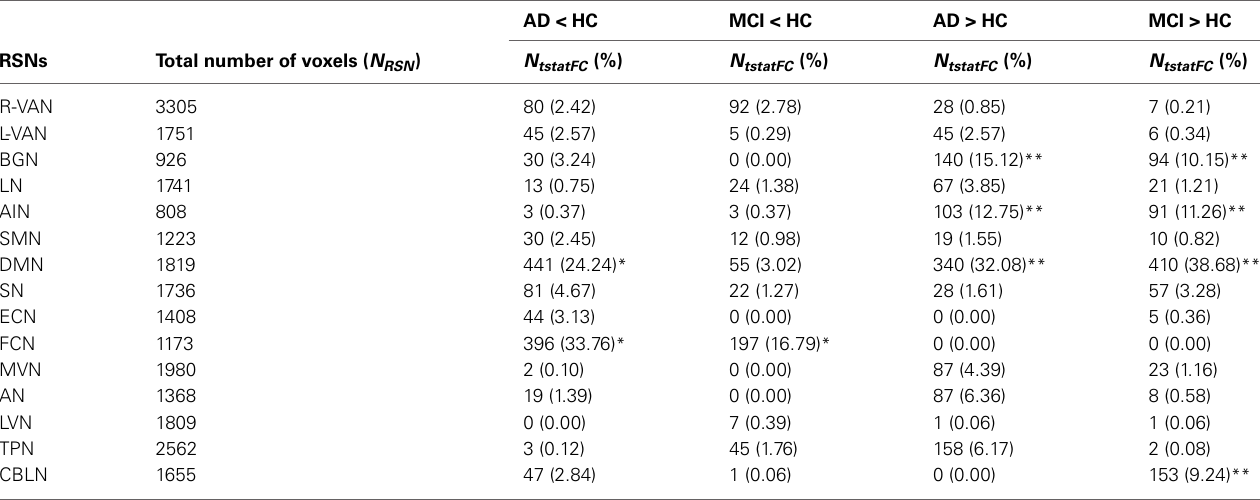
Table 3 | FC alterations within the 15